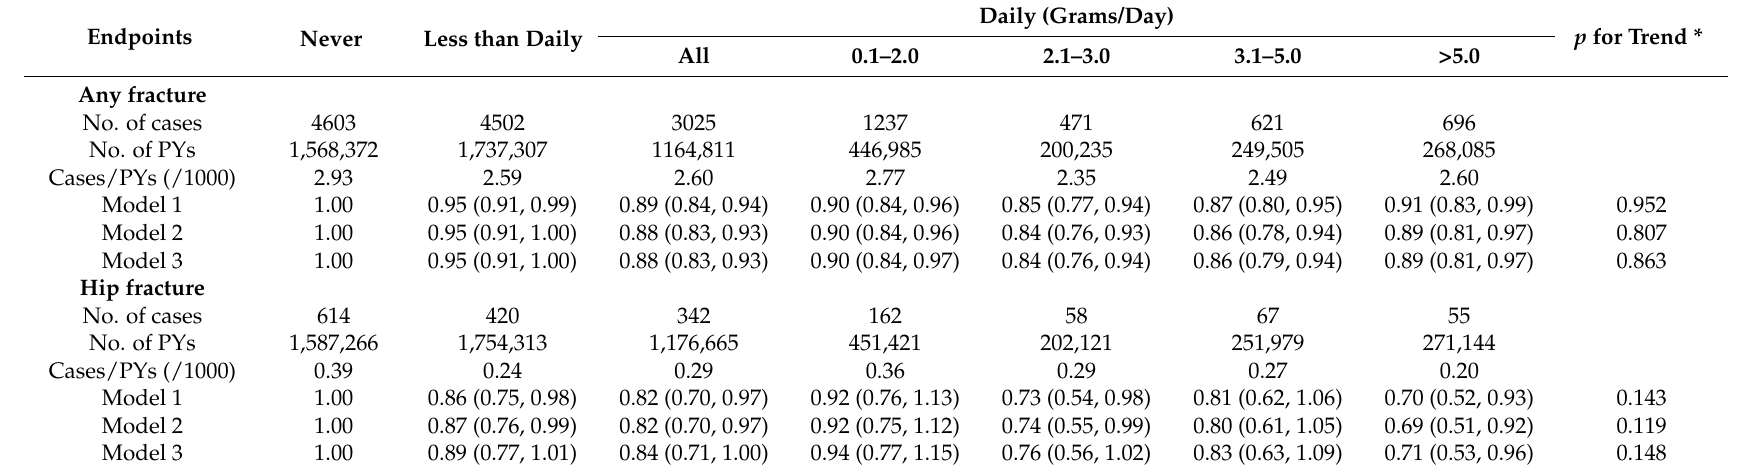
Table 2. HRs (95% CIs) for associations between tea consumption (in grams/day) and risk of fracture among 453,625